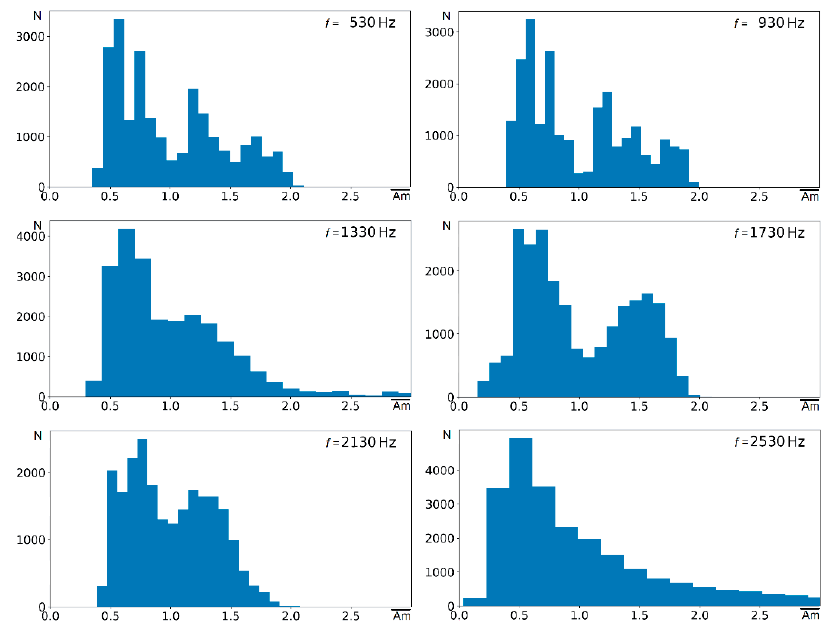
Figure 8. Histograms of the original spectra are plotted for six frequencies (the frequency values are given in the figures).